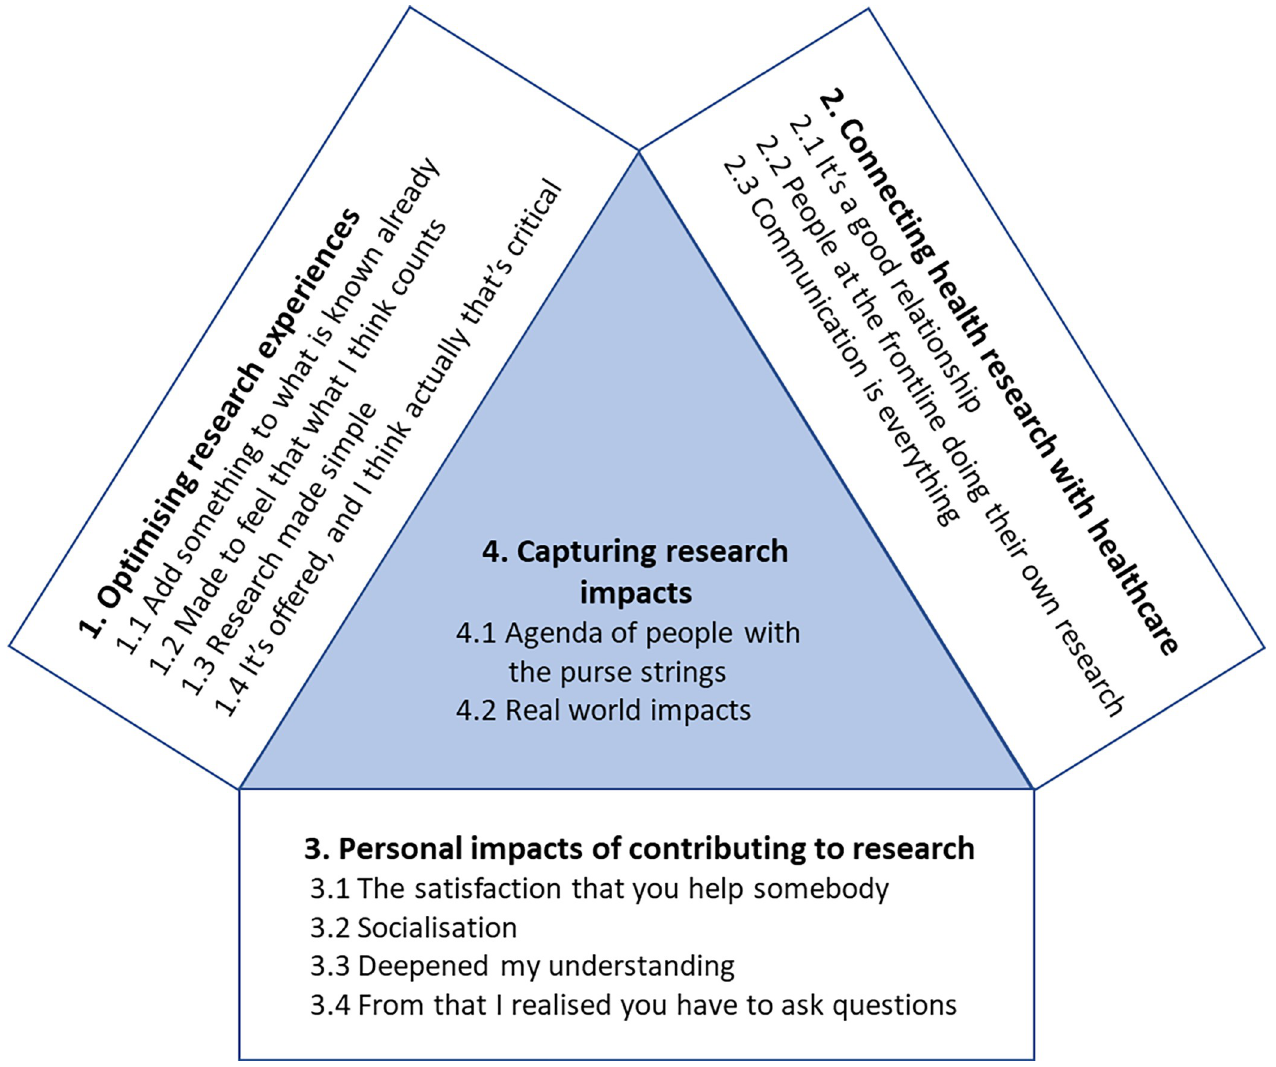
Fig 1. Summary of the identified themes. Themes 1 and 2 represent strategies for health researchers to optimise the experience for contributors and improve the connection between health research and health care. Theme 3 reports the perceived impacts of contributing to research for those who volunteer as participants or public advisors. These three themes converge on the final theme (theme 4) which describes the types of impact that were identified as important.